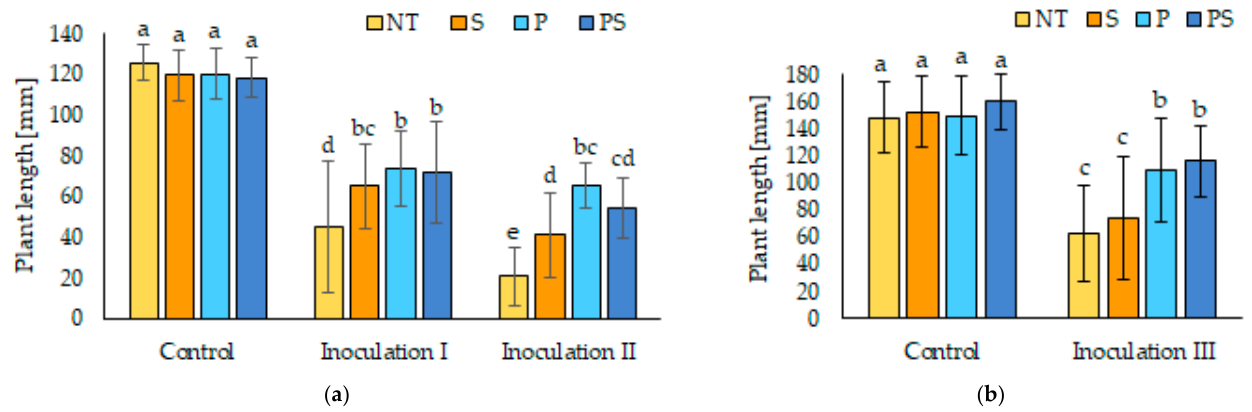
Figure 3. The length of maize plants in the control soil or soil contaminated with F. culmorum ; ( a ) inoculation I and II, ( b ) inoculation III measured 7 days after sowing (NT–not treated seeds, S–seeds coated with SAP, P–seeds dressed with pesticides, and PS–seeds dressed with pesticides and coated with SAP). The errors of the mean values are expressed as standard deviation ( ± SD). Different letters indicate statistically significant differences by LSD test ( α =